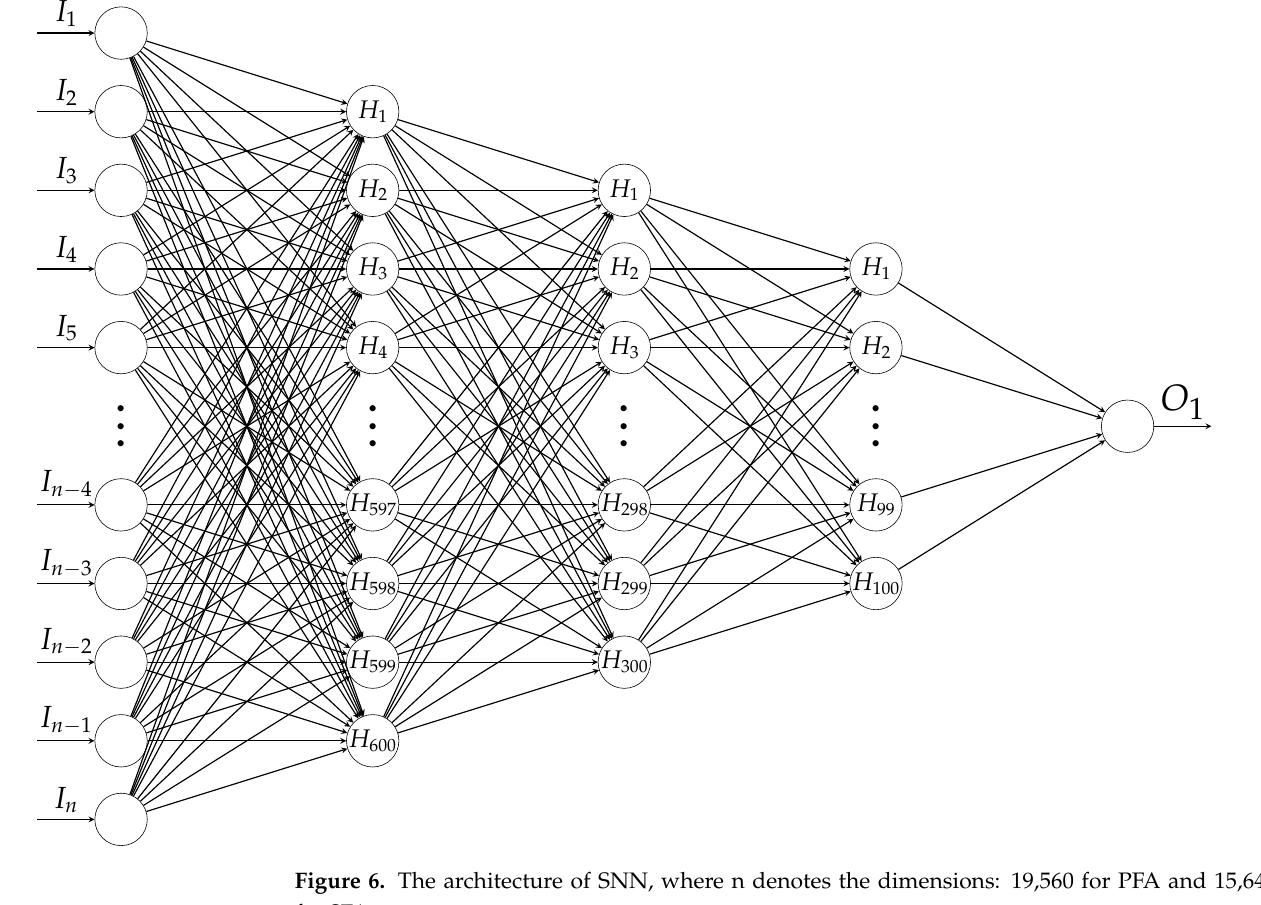
Figure 6. The architecture of SNN, where n denotes the dimensions: 19,560 for PFA and 15,648 for